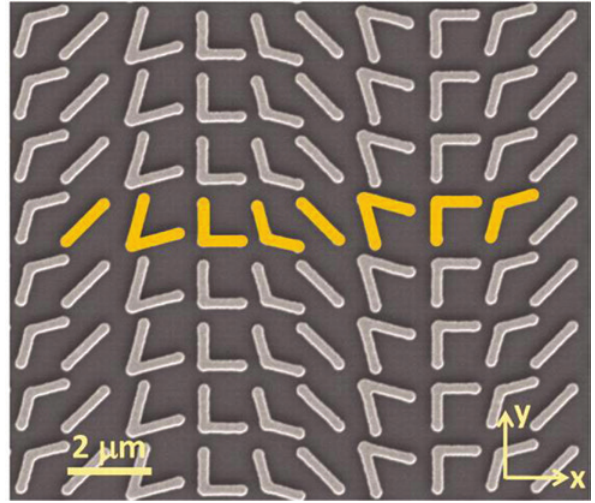
Figure 3: Metasurface utilizing V-shaped nanoantennas. From Ref. [5]. Reprinted with permission from